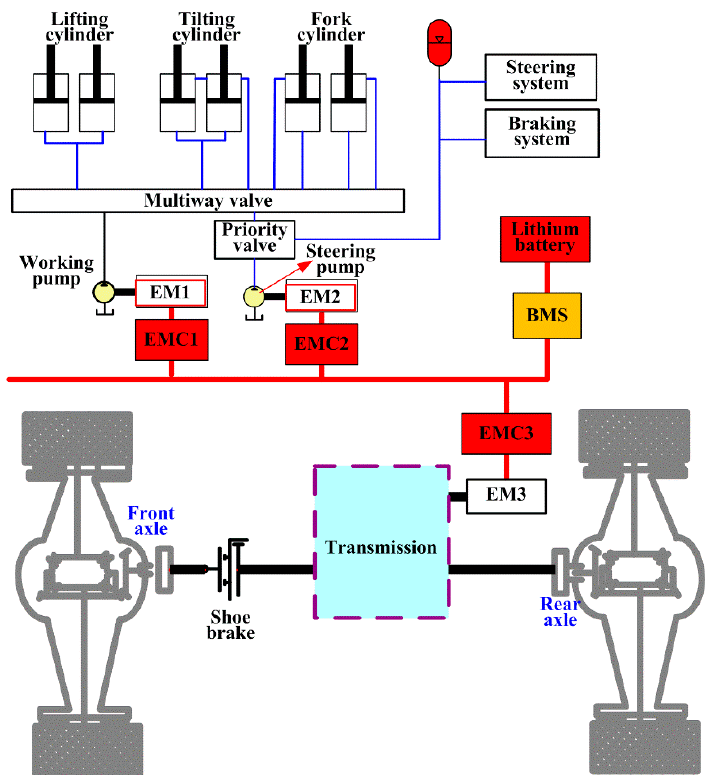
Figure 1. Structure of an electric heavy forklift (EHF). Appl. Sci. 2020 , 10 , x FOR PEER REVIEW